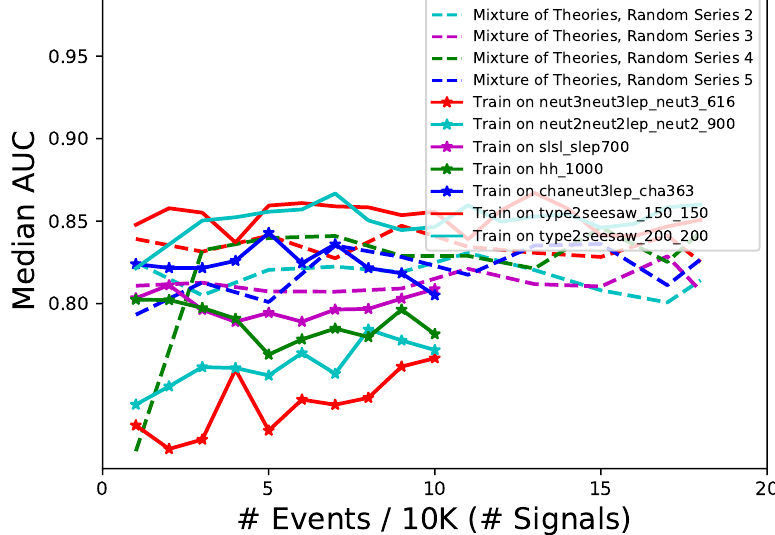
Figure 5 . The figure shows the median AUCs of the trained ML models for channels with leptonic final states, tested on signals from the hackathon data . For the dashed line, the training processes based on an increasing number of signals with a point size of 10k are repeated 5 times per channel in random series. The steps to add signals to the training set are (7, 2) for (channel 2a, channel 2b), while all channels start with the ML model with only one signal in the training set. For the star-shaped lines we use only 1 single signal and increase the number of events gradually in steps of 10k. The solid lines are similar to the star lines trained with a single signal. However, additional events are generated to extend the